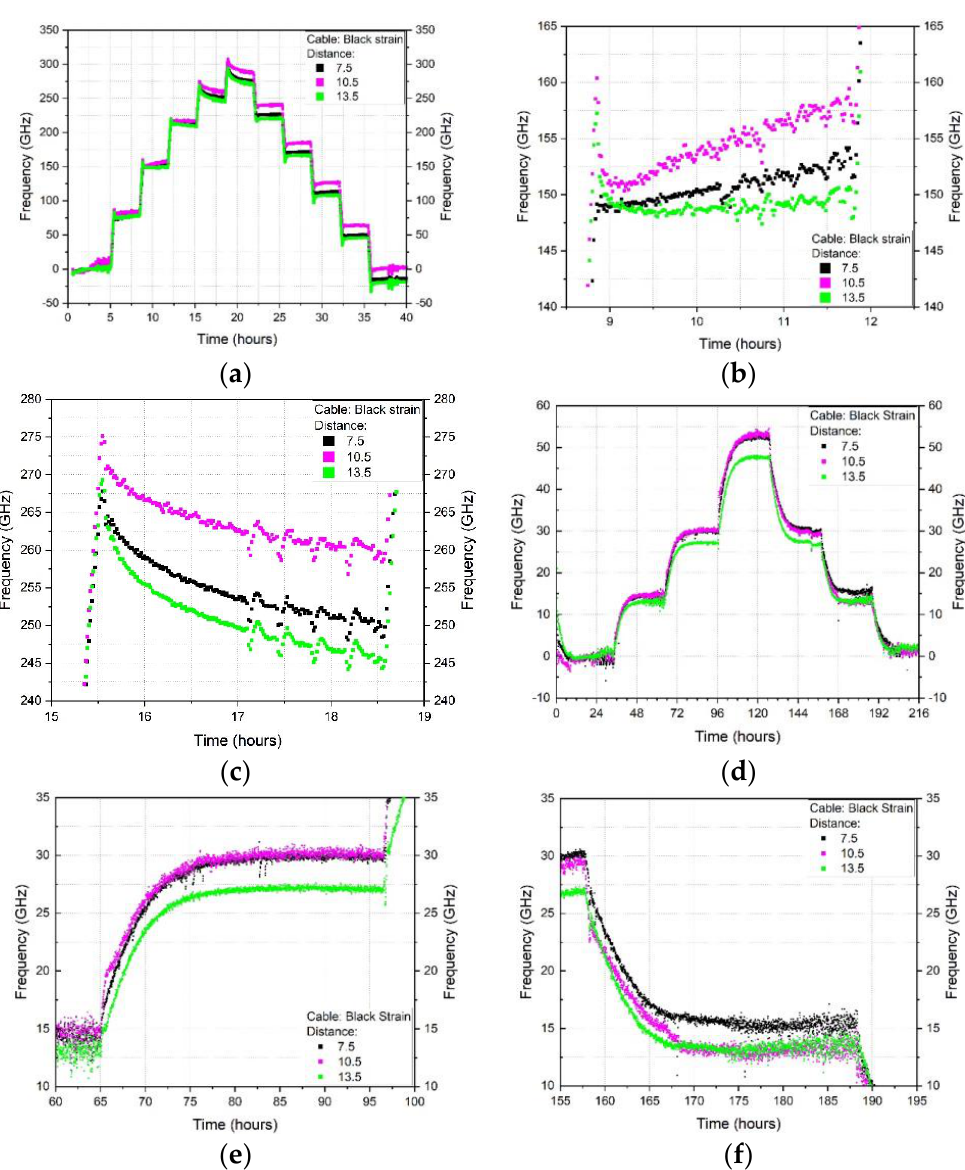
Figure 8. 2.0 mm tight buffered cable results for ( a ) 1st heating-cooling cycle ( b ) temperature drift at 40 °C over 3 h ( c ) temperature drift at 60 °C over 3 h ( d ) increasing and decreasing humidity ( e ) humidity drift at increasing 30% rel. H over 30 h and ( f ) humidity drift at decreasing 30% rel. H. over 30 h.